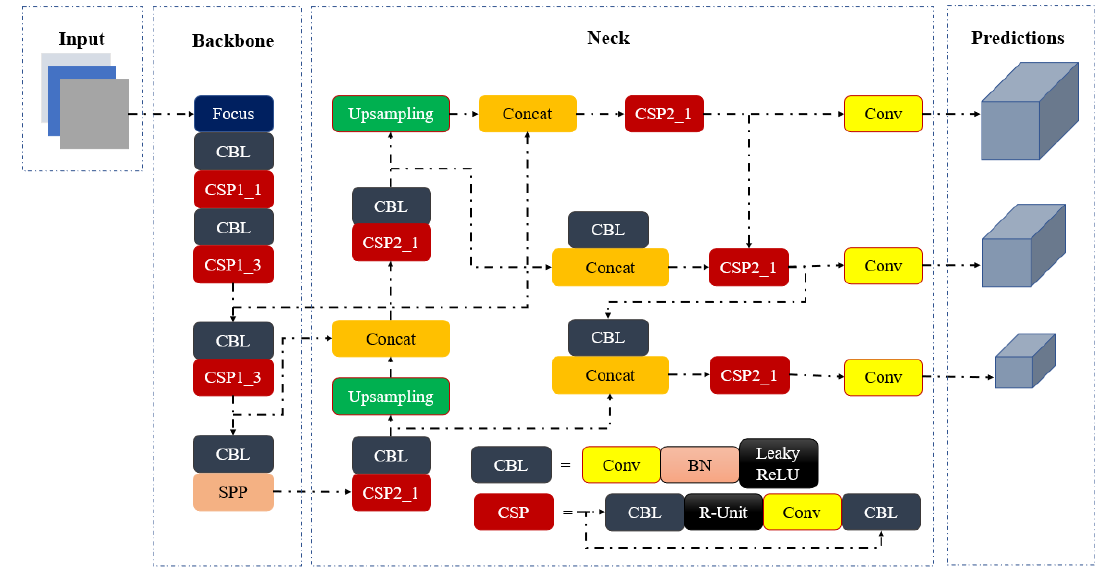
Figure 4. Network structure of YOLOv5.